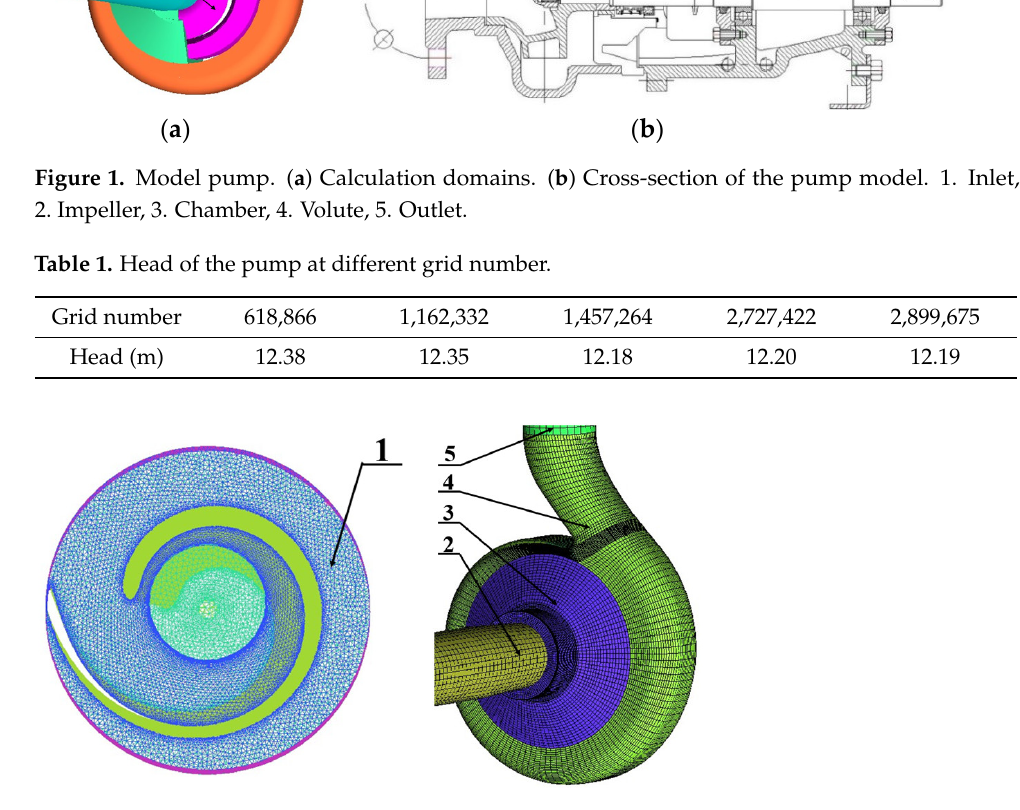
Figure 2. Mesh of the pump. 1. Impeller, 2. Inlet, 3. Chamber, 4. Volute, 5. Outlet. Table 1. Head of the pump at different grid number.